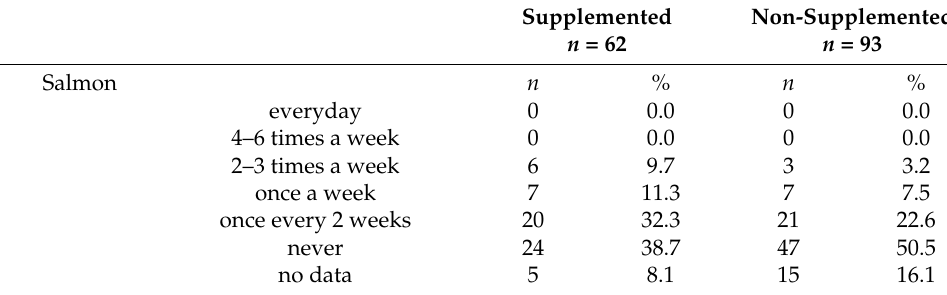
Table A3. Fish consumption among investigated